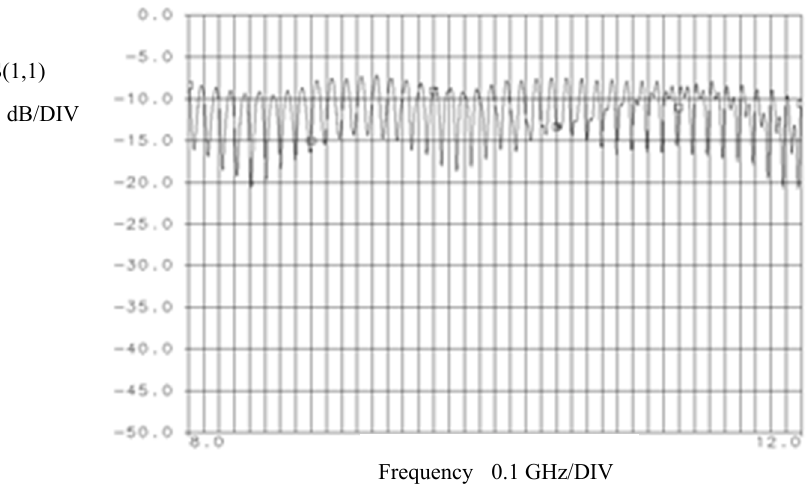
Figure 6. Experimental measurements of reflection coefficient in dB vs frequency without the glass (mosaic) layer.